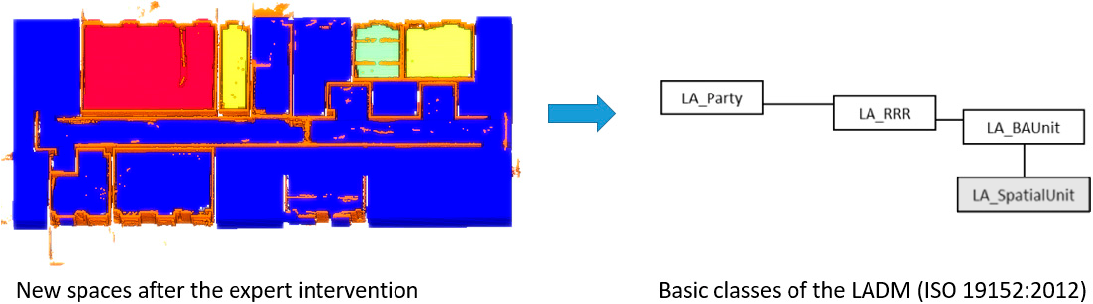
Figure 16. New spaces with the same rights and ownership obtain the same label and color and form a new physical space that can be linked to the